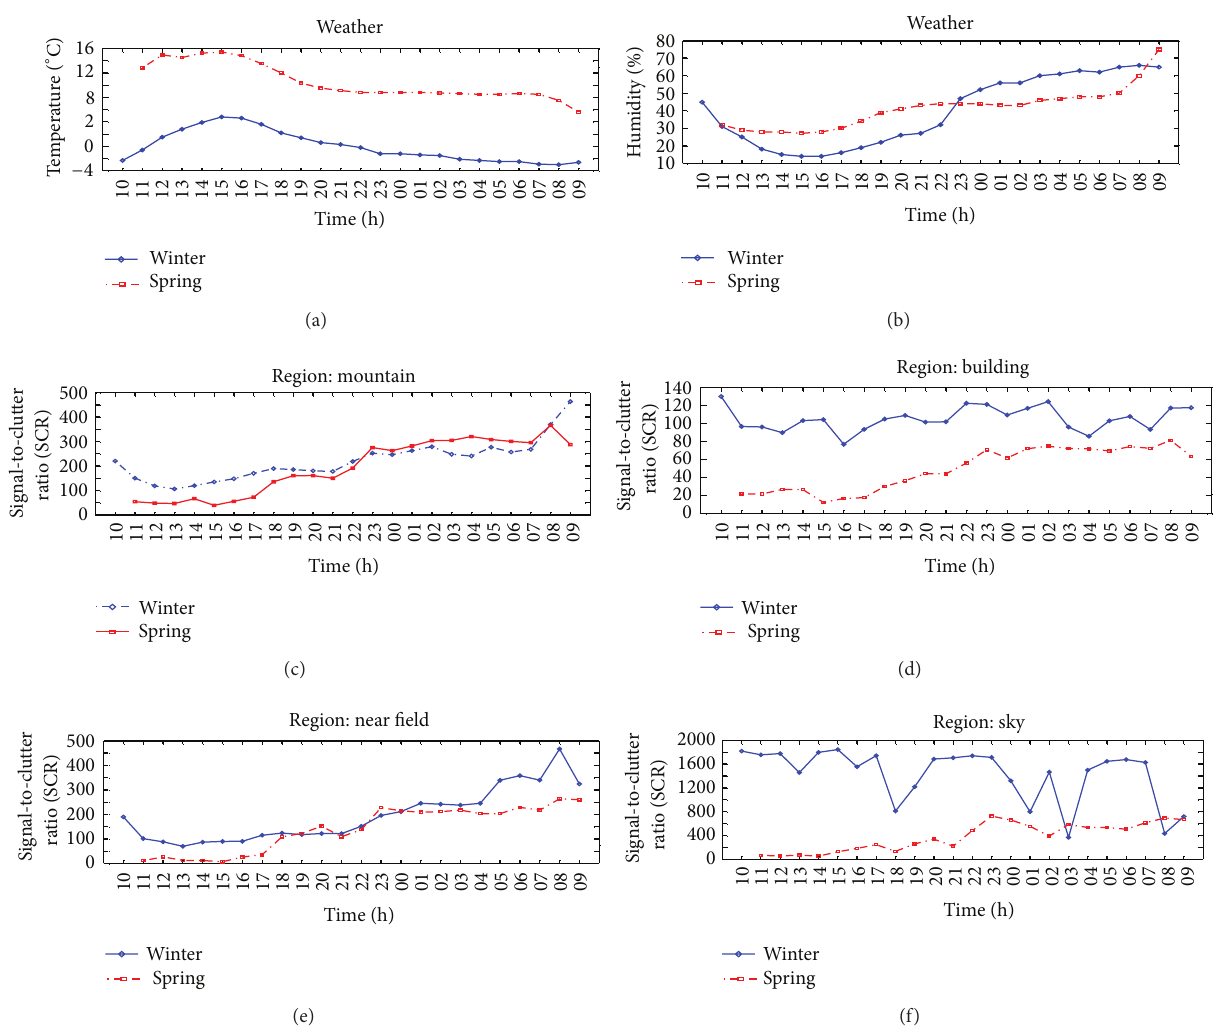
Figure 14: SCR comparison between winter and spring: (a) mountain, (b) building, (c) near field, and (d) sky.